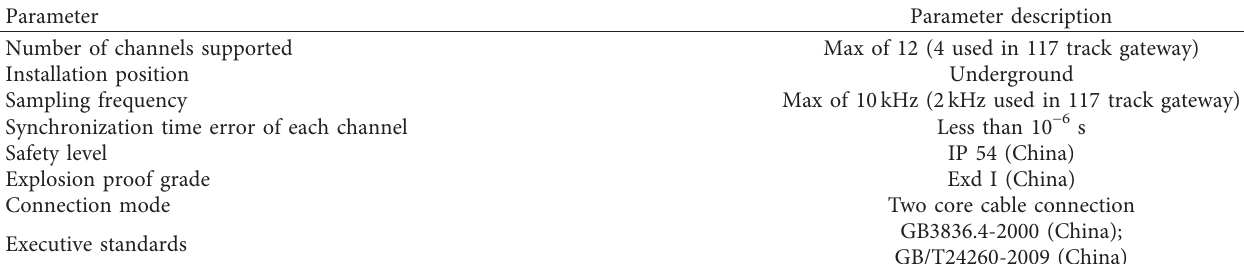
Table 1: Parameters of the acquisition instrument used in the MS system of 117 track gateway.